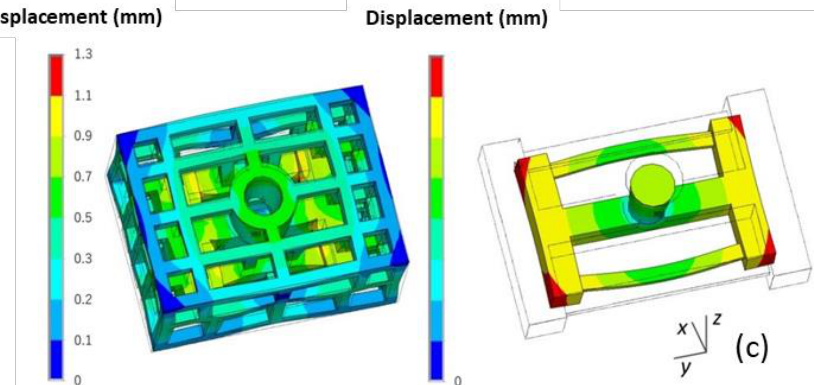
Figure 18. The deformation (equivalent displacement and deformed geometry) of the skeletal sand mold and casting (the wire frame is the original geometry, the rendered one is the final shape with magnified deformation, magnification × 20): ( a ) 500 s; ( b ) 1500 s and ( c ) 4500 s. This casting mainly contracted during the casting process, especially along the y direction.